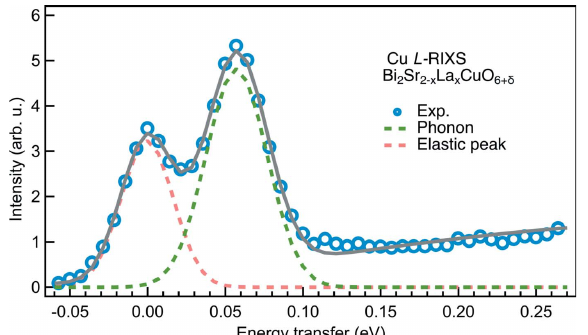
Figure 5 Bi 2 Sr 2– x La x CuO 6+ (cid:4) ( x = 0.6) Cu L -edge RIXS spectrum at q k = 0.635 A ˚ (cid:6) 1 projected along the crystalline a -axis acquired for 10 min using the grating combination of VPG2 and SVLS2 with an energy resolution of 38 meV (Li et al. , 2020). The pink dashed line is the elastic peak and the green dashed line is the bond-stretching phonon. The black solid line is a cumulative fit of the components and a linear background from paramagnons.